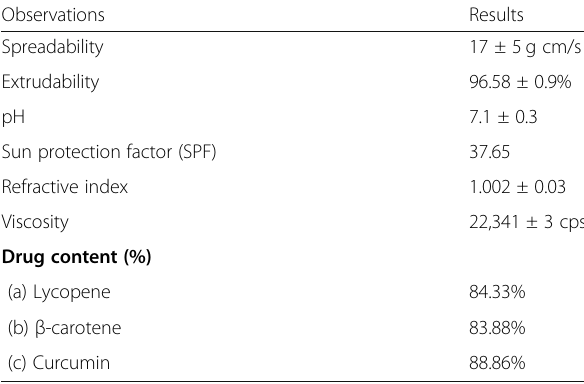
Table 3 Various evaluation parameters of microemulsion- containing sunscreen cream